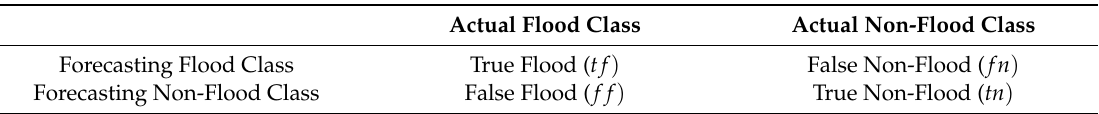
Table 12. Confusion matrix for binary classification and the corresponding array representation used in this study.